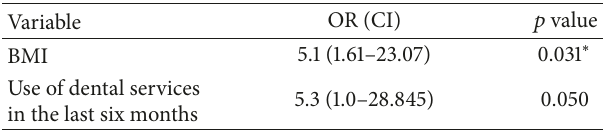
Table 5: Conditional logistic regression (stepwise backward entry